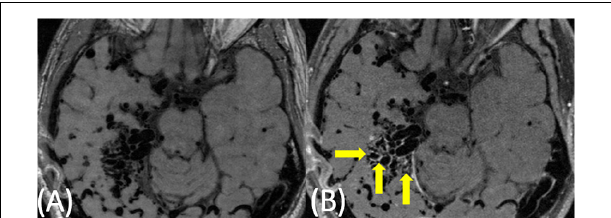
FIGURE 2 | 63-year-old female with a predominantly left frontal AVM. On pre-contrast VW-MRI (A) , no intrinsic T1 hyperintensity is present. On post-contrast VW-MRI (B) , there were multiple areas of hyperintensity at the vessel wall as well as perivascular hyperintensity within the nidus (yellow arrows).